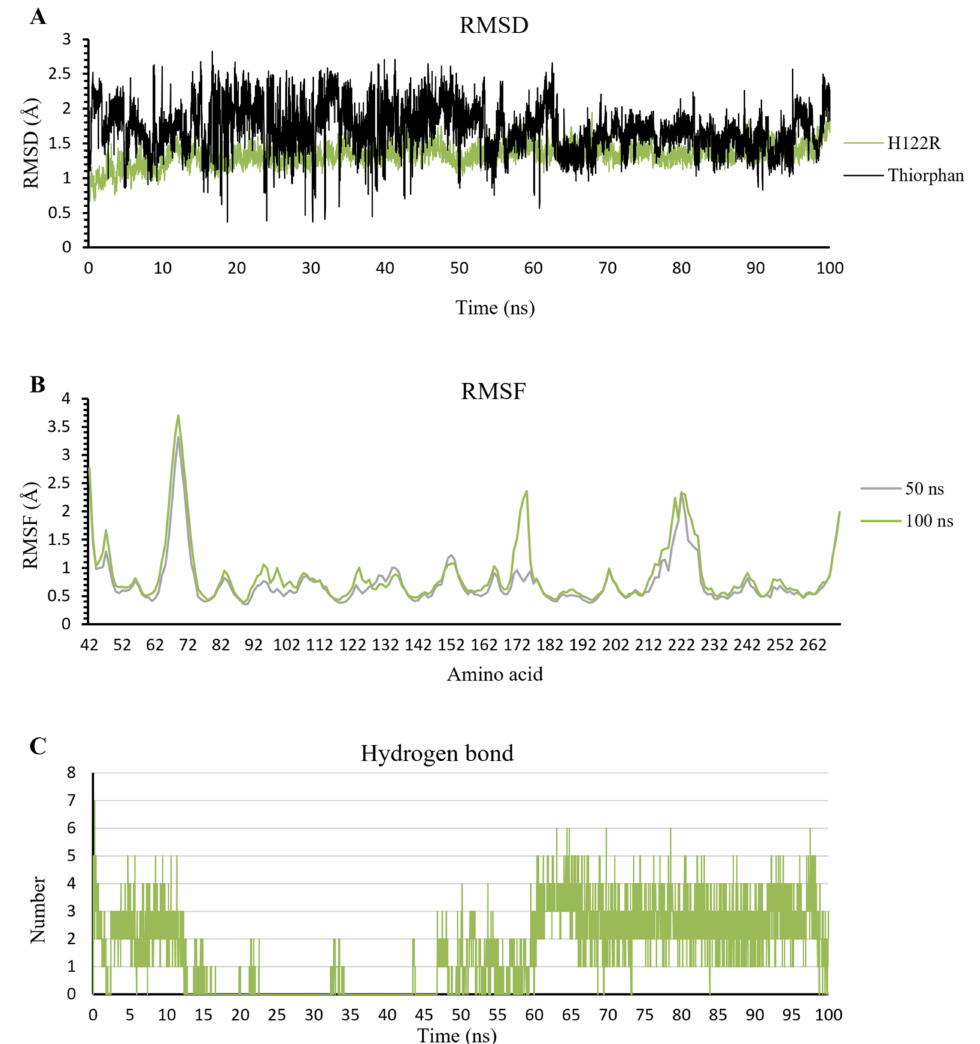
Figure 11. The result of thiorphan/H122R complex in 100 ns simulation time. ( A ) The RMSD value of H122R protein and thiorphan. ( B ) The RMSF value of 50 ns and 100 ns simulation time. ( C ) The av- erage number of H-bonds formed by thiorphan with H122R mutant protein during MD